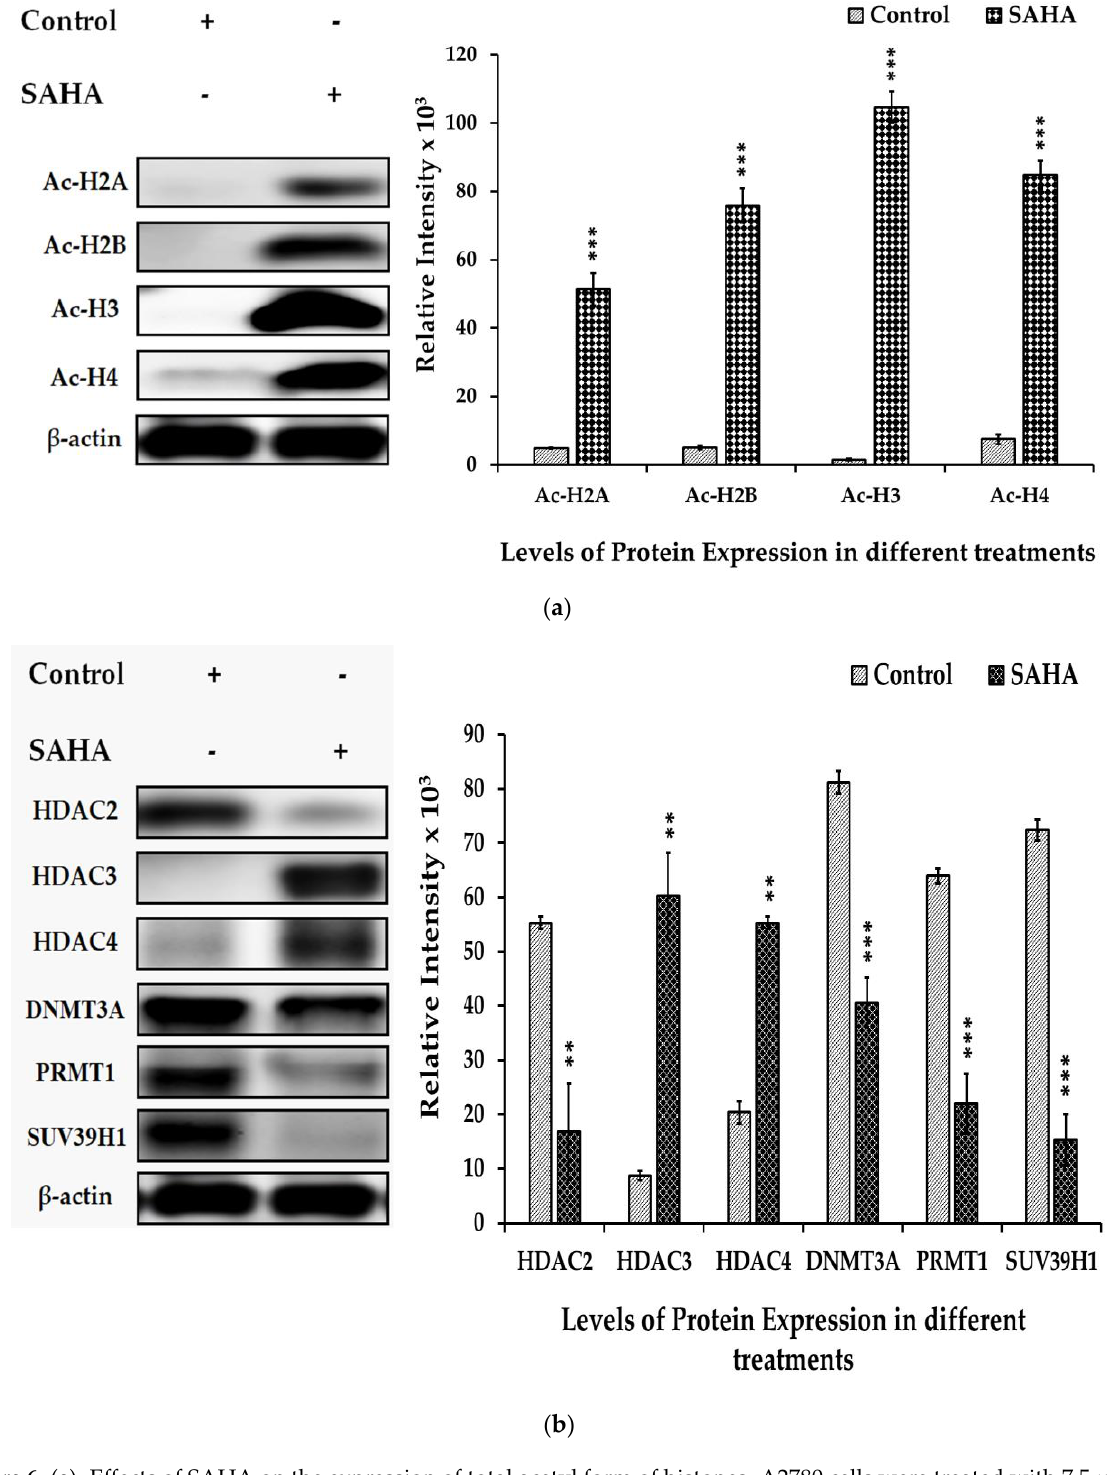
Figure 6. ( a ). Effects of SAHA on the expression of total acetyl form of histones. A2780 cells were treated with 7.5 µM of SAHA for 24 h. Western blotting was performed with the indicated level of acetylated histones such as H2A, H2B, H3, and H4. The bar graphs represent total acetylation of histones following treatment with SAHA, as determined by densitometry of bands. All data are presented as the mean ± SD of at least 3 independent experiments. *** p < 0.001. ( b ). Effects of SAHA on the expression of HDACs and DNMTs/HMTs in A2780 cells. Western blotting was performed to determine the levels of HDAC2, HDAC3, HDAC4, DNMT3A, PRMT1, and SUV39H1. The bar graphs represent HDACs and DNMTs/HMTs following treatment with SAHA, as determined by densitometry of bands. All data are presented as the mean ± SD of at least 3 independent experiments. ** p < 0.01; *** p < 0.001 .